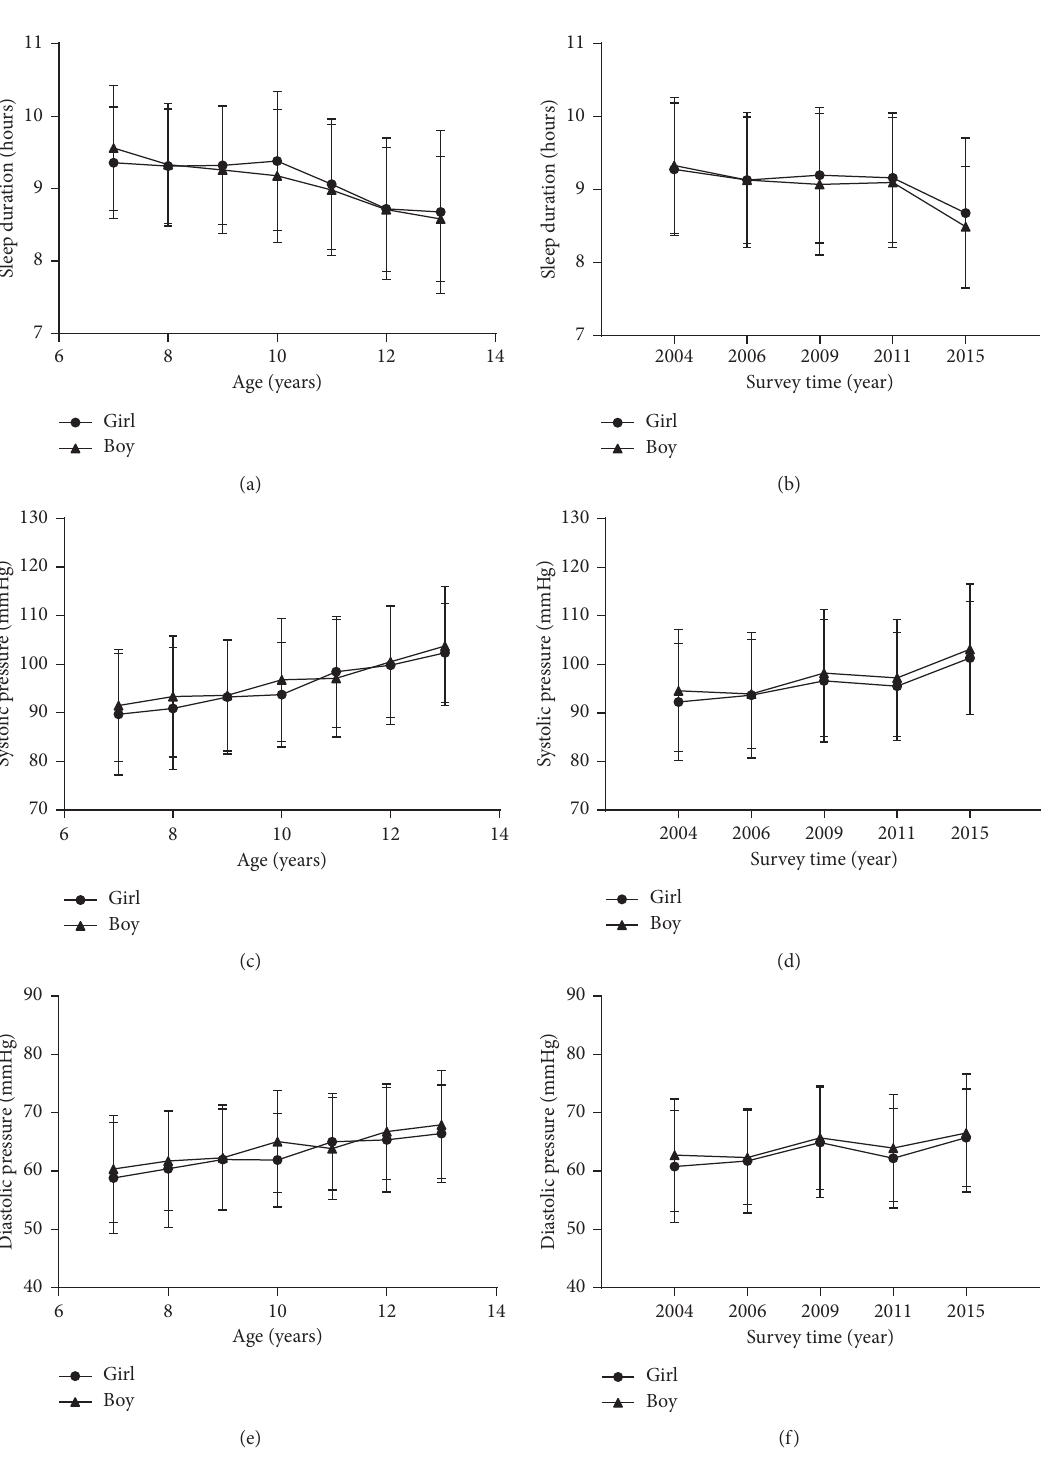
Figure 1: The trend of sleep duration and BP level (mean and error) with increasing age (a) and over survey time 2004–2015